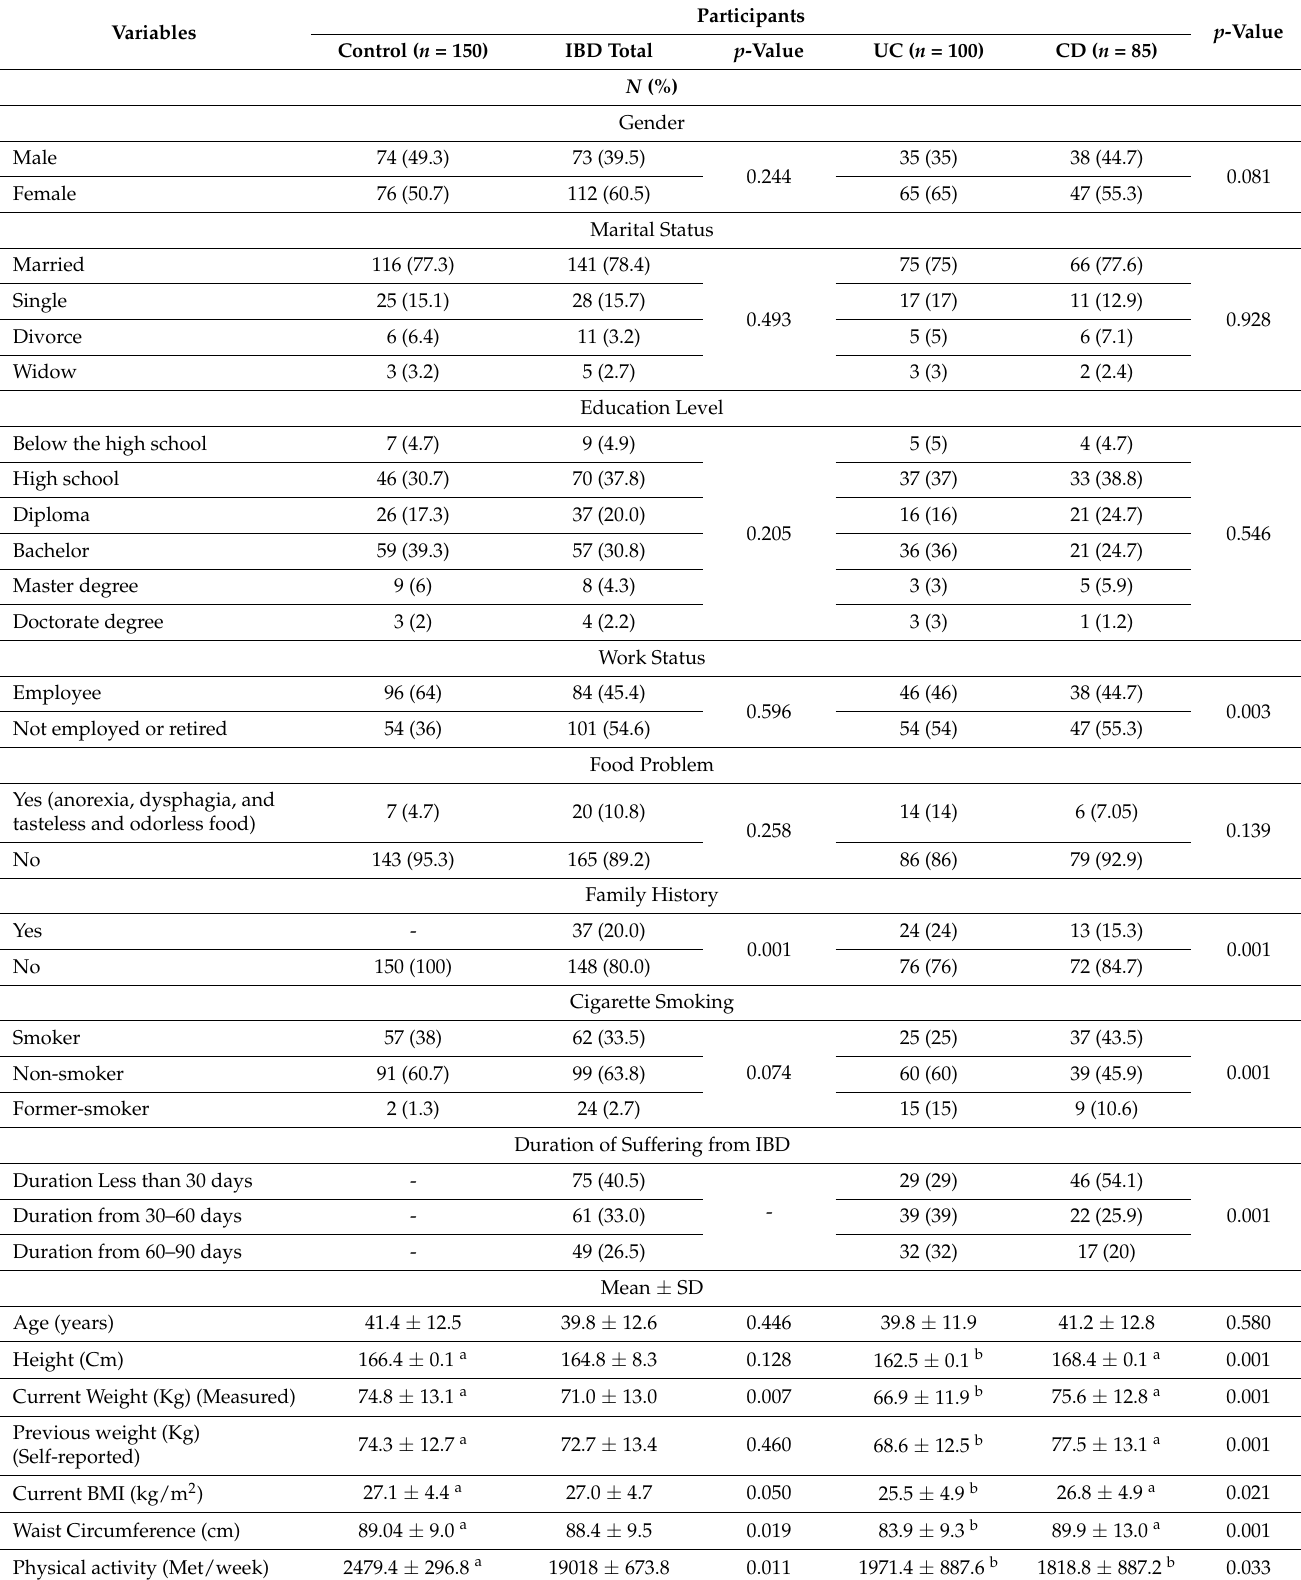
Table 2. Socio-demographic and anthropometric measurements of the study